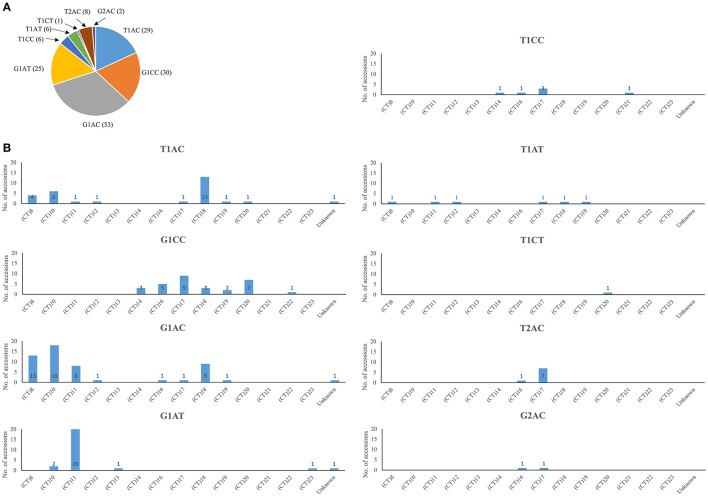
Waxy
haplotype frequencies in rice accessions used in the present study. (A)
Waxy SNP combinations (including the 23 bp InDel in exon 2) and numbers of associated accessions. (B) Association of (CT)n classes with SNP combinations.